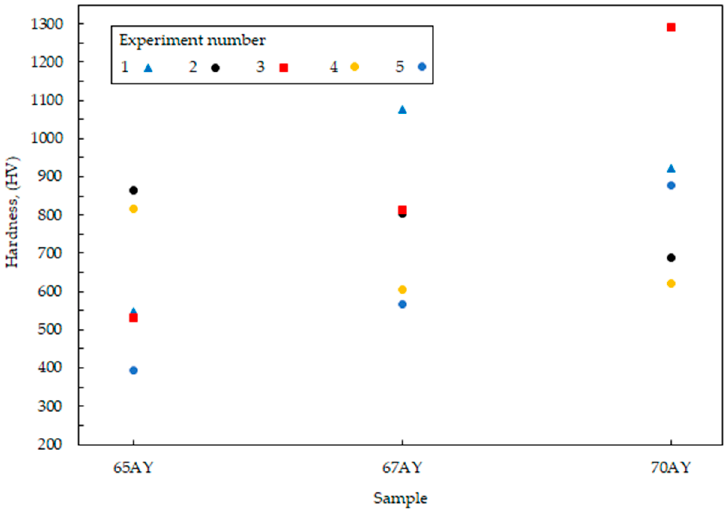
Figure 3. Vickers hardness values of 65AY, 67AY and 70AY eutectic ceramic composite